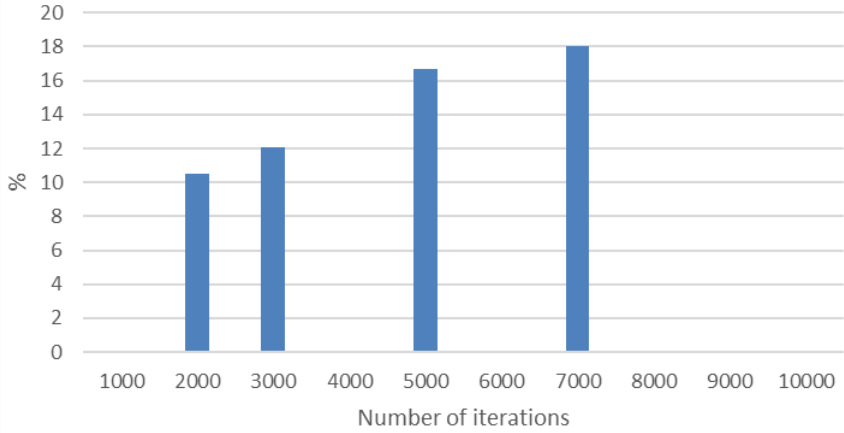
Figure 7. Dependence of the approximation accuracy on the number of iterations of the algorithm, with reference to the percentage error.